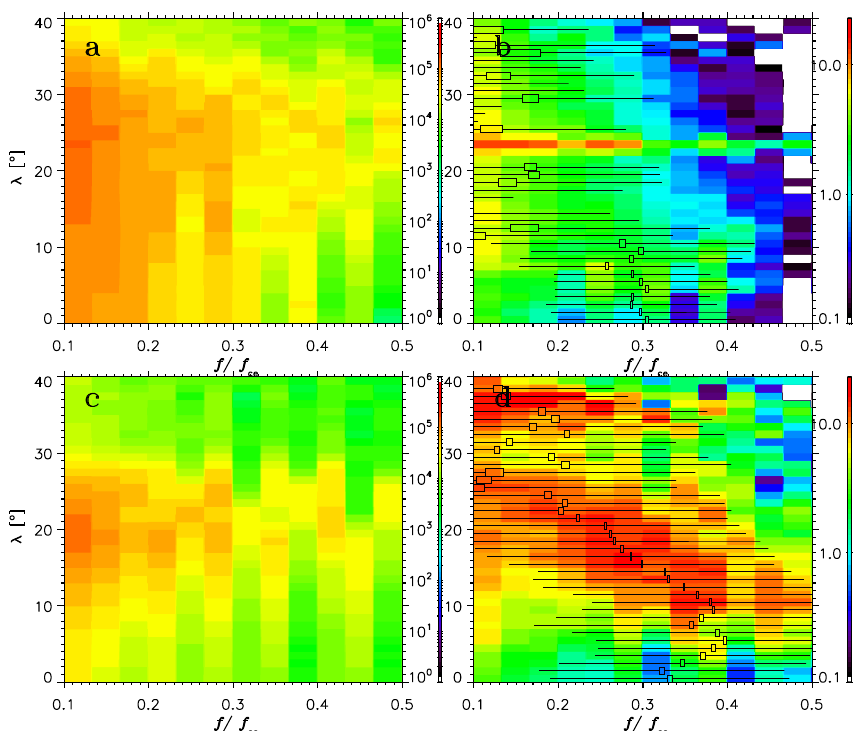
Figure 1. Number of measurements (left panels) and amplitude in pT (right panels) of chorus waves as a function of latitude obtained from 10 years of STAFF-SA instrument measurements onboard Cluster spacecraft on the nightside (top panels) and dayside (bottom panels) for 4 < L < 6. The peak frequency (data is fitted by a Gaussian function) for each 1 ◦ latitude range in right panels is indicated by a black